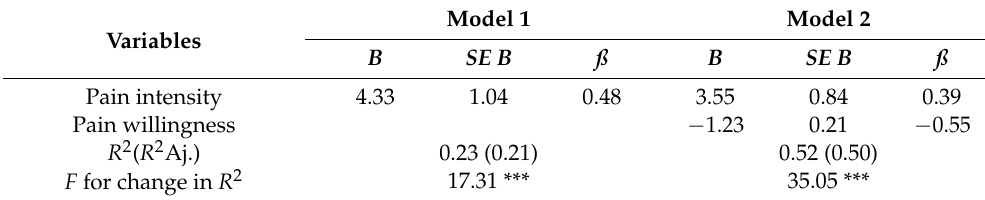
Table 3. Variables that contribute to psychological inflexibility in pain in headache group.